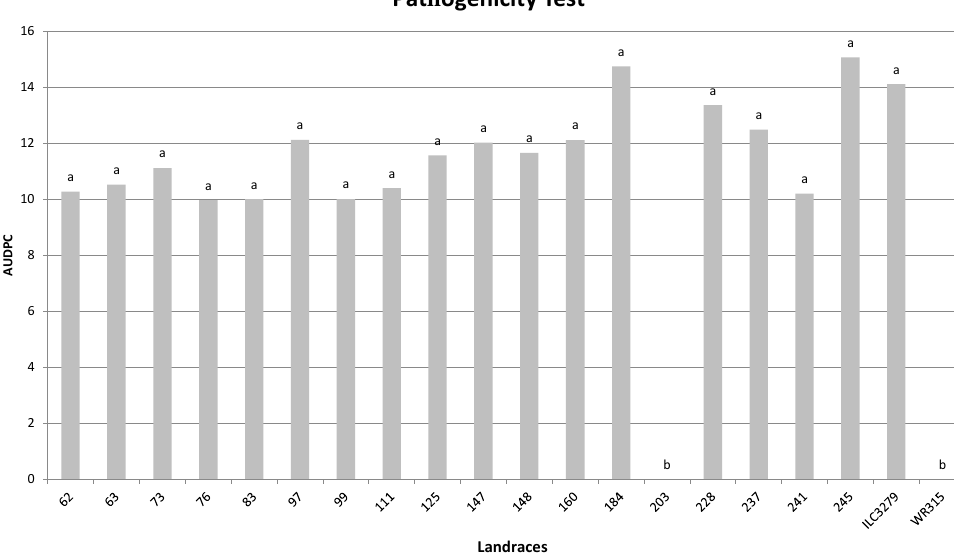
Figure 1. Average Area Under the Disease Progress Curve (AUDPC) obtained from pathogenicity tests carried out in controlled conditions on Italian chickpea landraces inoculated with Fusarium oxysporum f. sp. ciceris race 5 ( Foc 5). Foc 5-susceptible ILC3279 and Foc 5-resistant WR315 were included as controls. Accessions with letters in common above the columns are not significantly different ( P = 0.05), according to Tukey’s